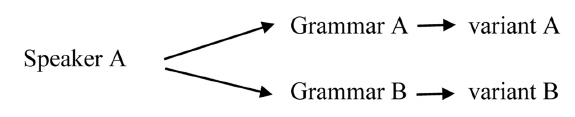
FIGURE 1 | Functionally equivalent variants (Rosenbach, 2002, p.